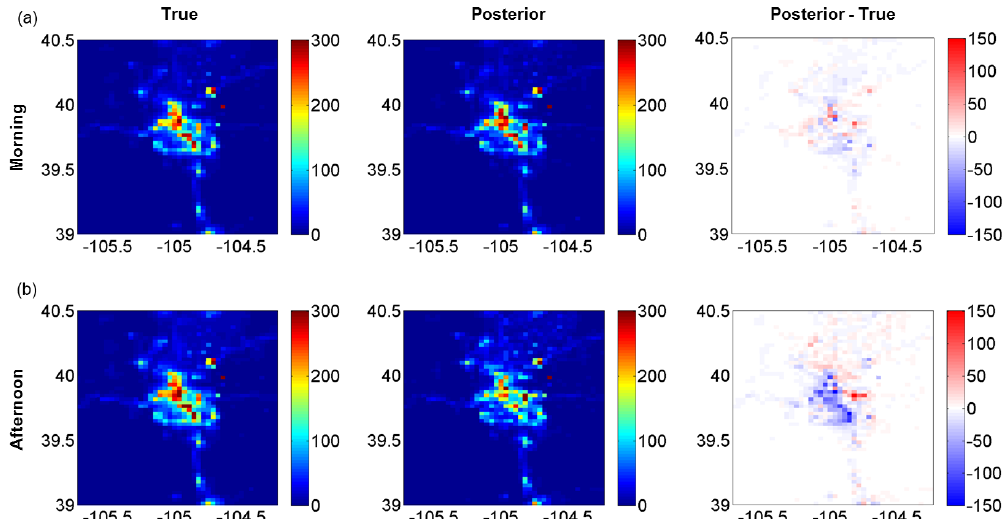
Figure 8. The emission estimation results in ENS.1 at 09:00MST (a) and 16:00MST (b) on 3 July of true and posterior emissions and the difference between true and posterior emissions (from left to right). The unit ismolkm − 2 h − 1